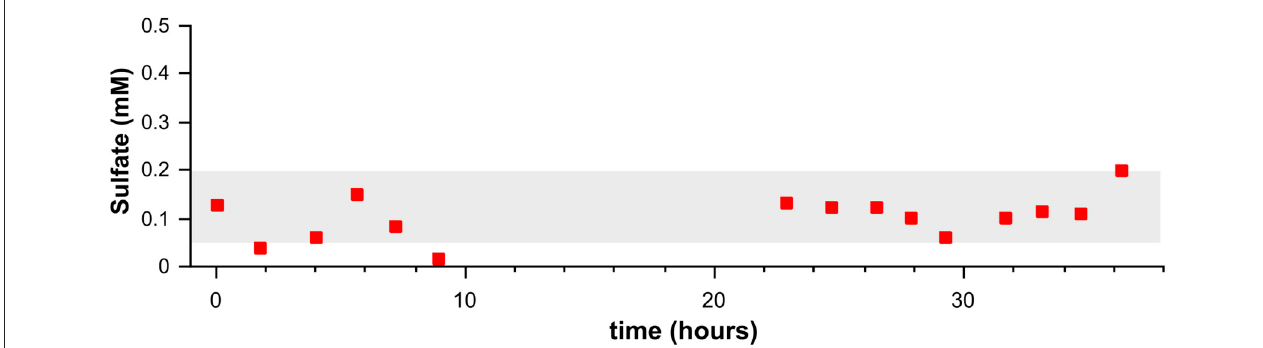
FIGURE 6 | Sulfate concentrations (red squares) from samples extracted by pore water press during a time frame of 36h. They gray band represents ± 1 sd of the average sulfate concentration for all sub-SMT samples in the Fall core. The sediment core (Fall 2013) was retrieved 2 days prior to when pore water pressing started ( t = 0